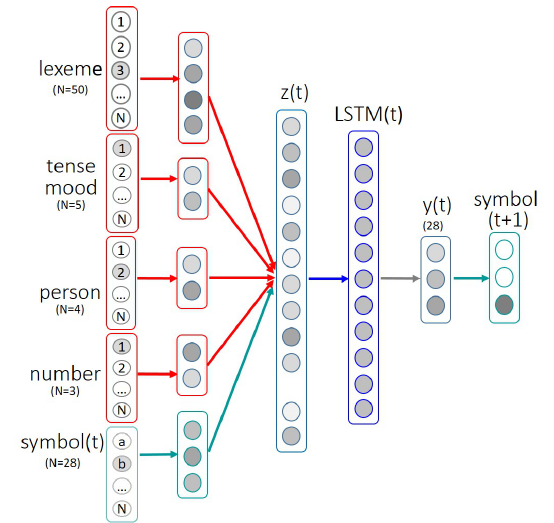
Figure 1. Functional architecture of the recurrent LSTM. Input vector dimensions are given in parentheses. Inputs are mapped onthe projection layer z(t) that is input to the recurrent layer LSTM(t) . Adapted from